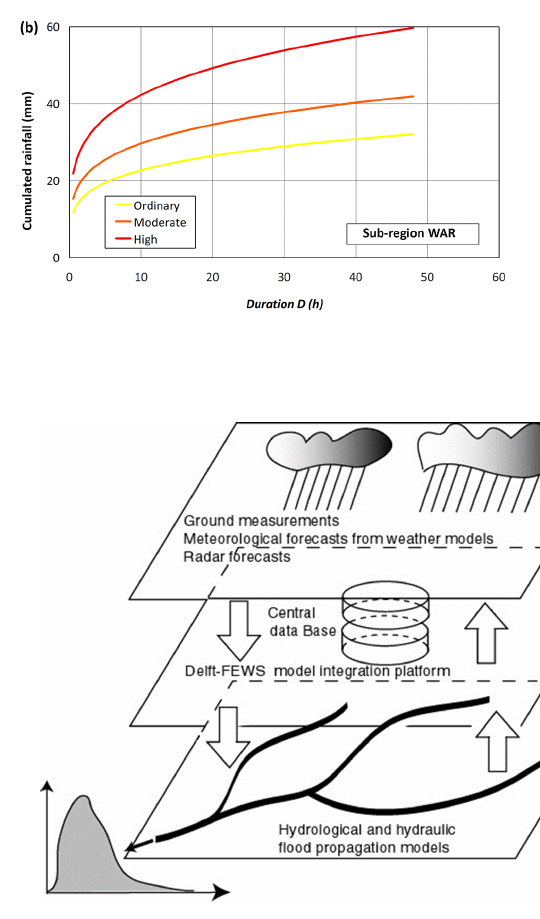
Figure 8. General architecture of the Delft-FEWS open flood fore- casting platform (after Verwey et al.,